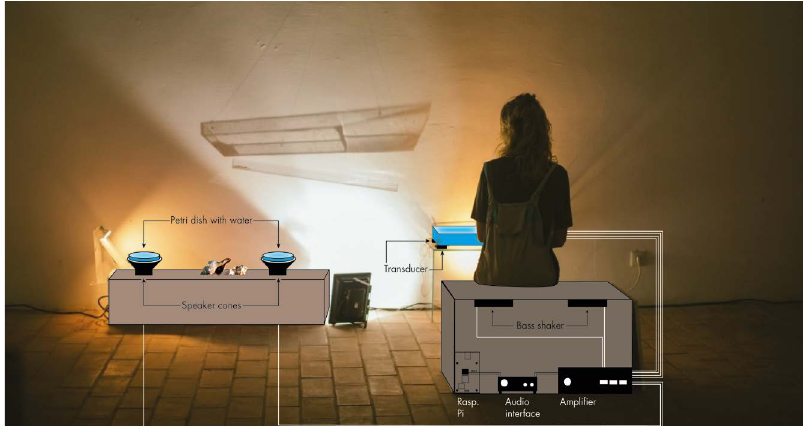
Figure 26: Technical diagram . Installation structure. © Isla